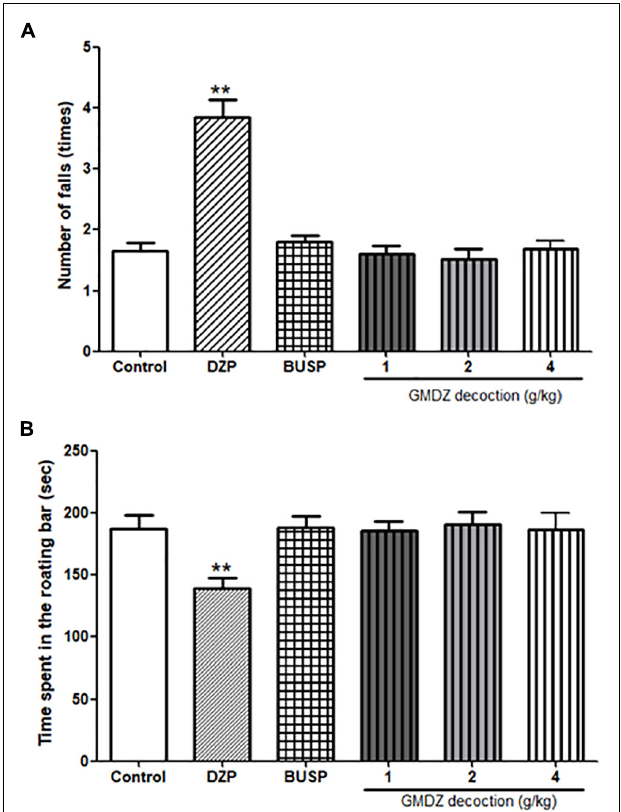
FIGURE 8 | Effect of GMDZ decoction on the rota-rod test. (A) Number of falls. (B) Time spent on the rotating bar. Value are represented mean ± SEM ( n = 12). ∗∗ P < 0.01 vs. control group. One way ANOVA with Student–Newman–Keuls post hoc